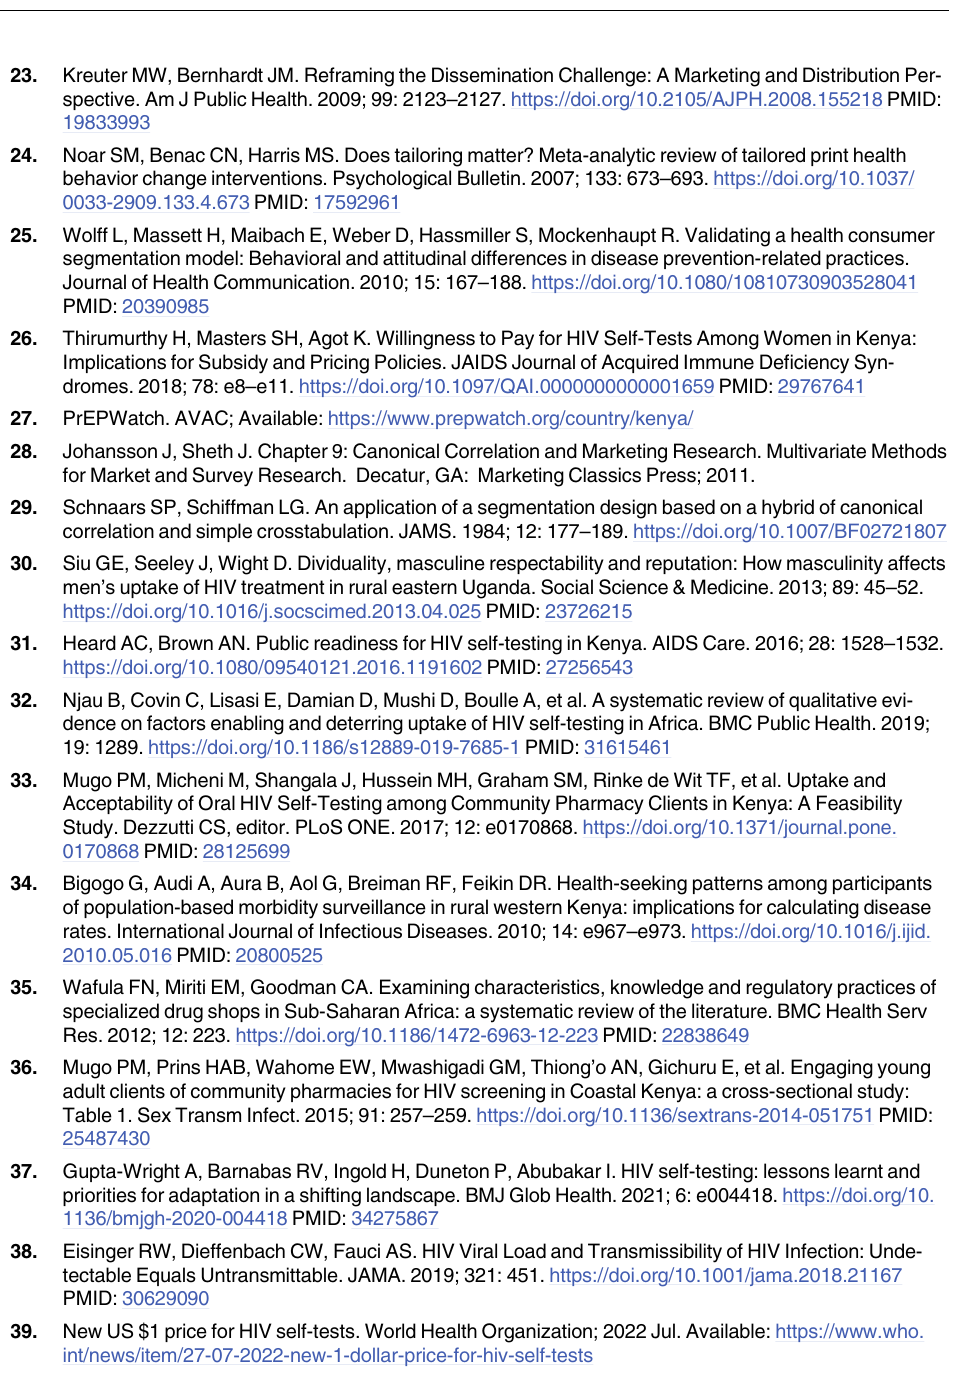
Table 1. Sex Transm Infect. 2015; 91: 257–259.https://doi.org/10.1136/sextrans-2014-051751PMID: